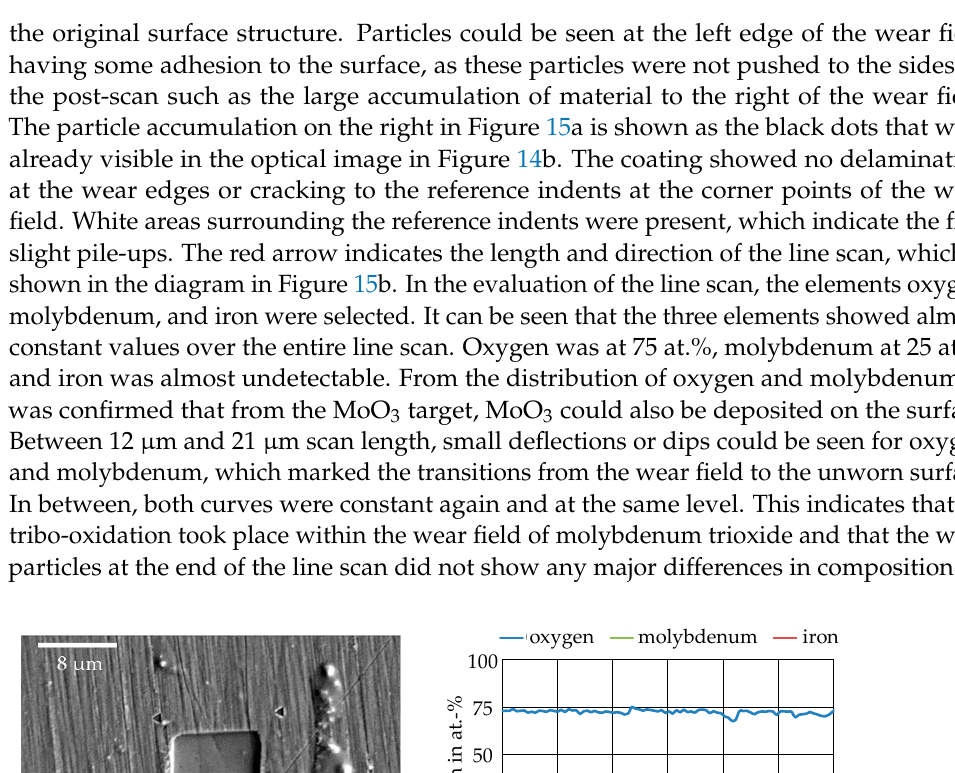
Figure 14. Light microscope images of the measuring locations for wear patches of the series with 35 P and 25 P: ( a ) For the Mo ‐ coating; ( b ) For the MoO 3 ‐ coating.